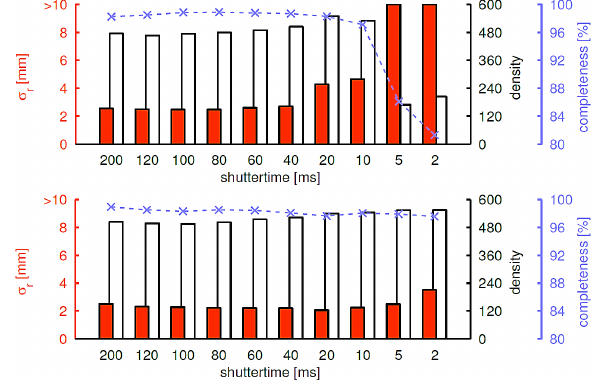
Figure 6: Accuracy in object space for a reference sphere without texture. Only the Kinect provides texture which leads to noisier, but still suitable results. The x-axis depicts the shuttertime, the left y-axis the standard deviation of the radial residuals. The upper figure shows the evaluation for images with 8 Bit depth, the lower one for 12 Bit.